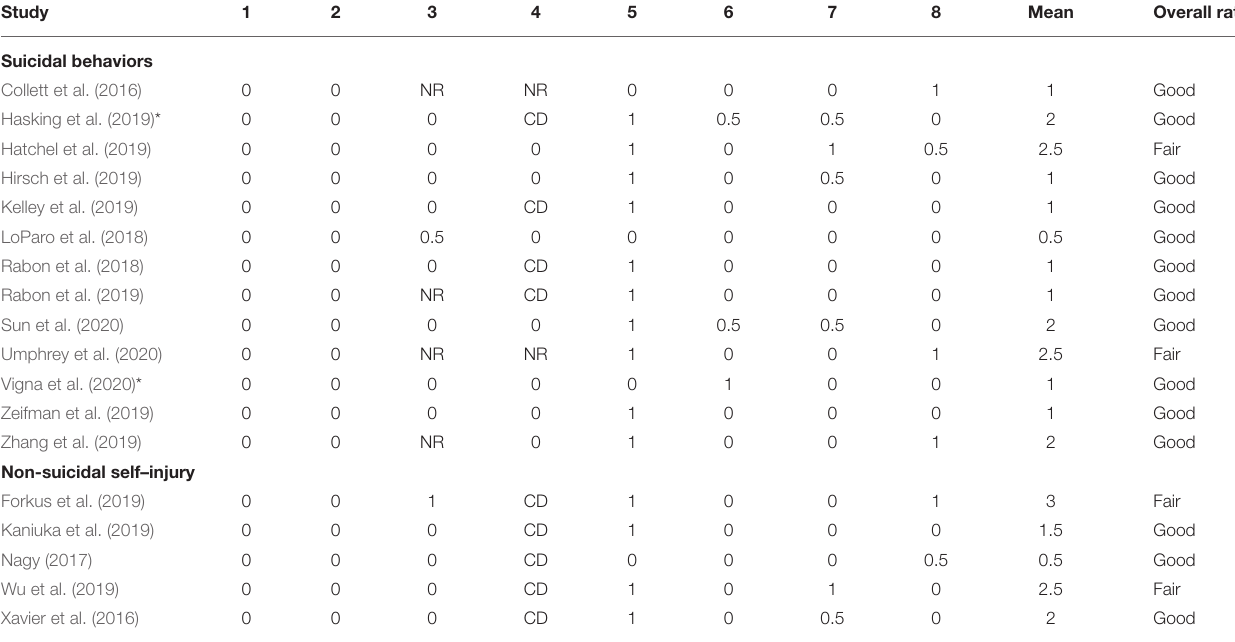
TABLE 1 | Quality assessment